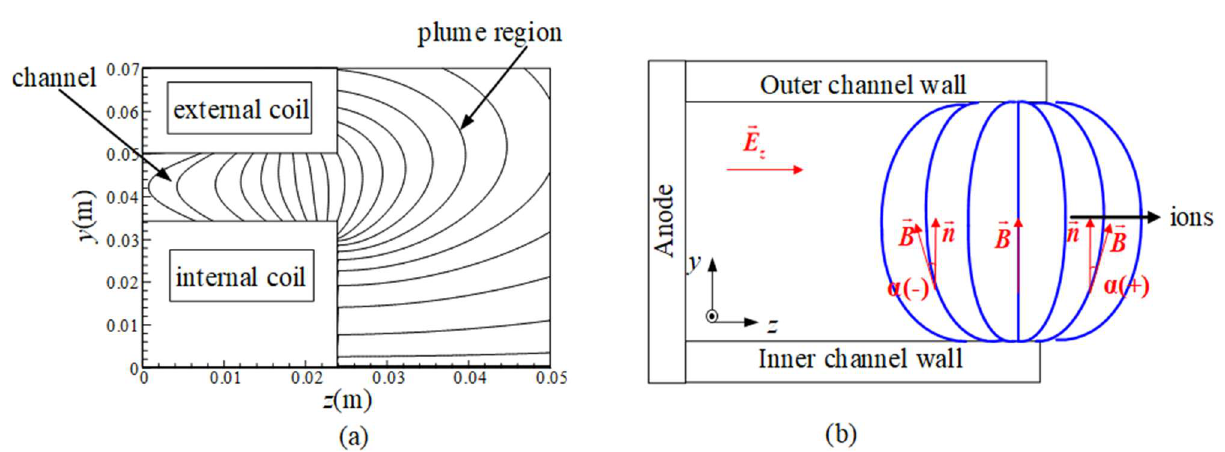
Figure 3. Schematic diagram of ( a ) typical magnetic field topology of SPT-100; ( b ) the simplified magnetic field configuration and tilt angle of magnetic field lines.